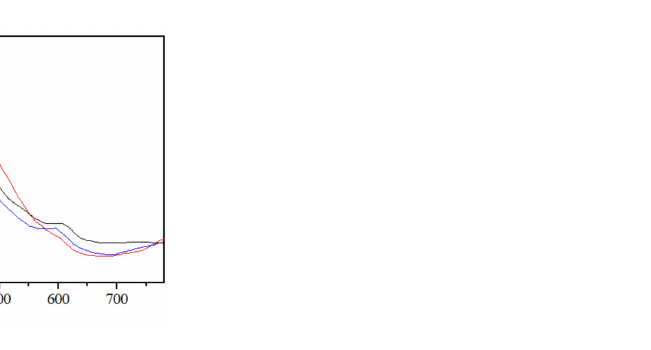
(DBT) = 4, V (oil)/V (methanol) = 1:1, C 0 = 320 ppmw, t = 30